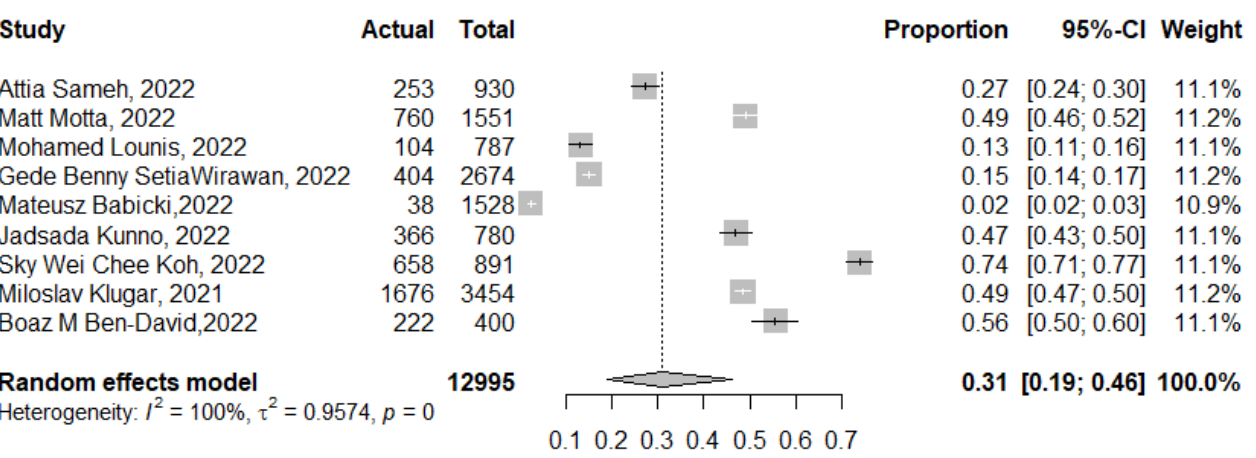
Figure 4. Forest plot of the pooled proportion of COVID-19 vaccine booster dose actual uptake. p = 0 denoted a p -value < 0.001.